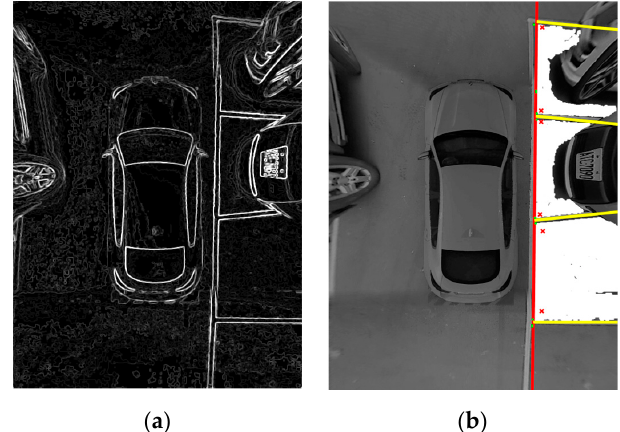
Figure 15. Road feature extraction. ( a ) Standard deviation feature map; ( b ) Region growing results.